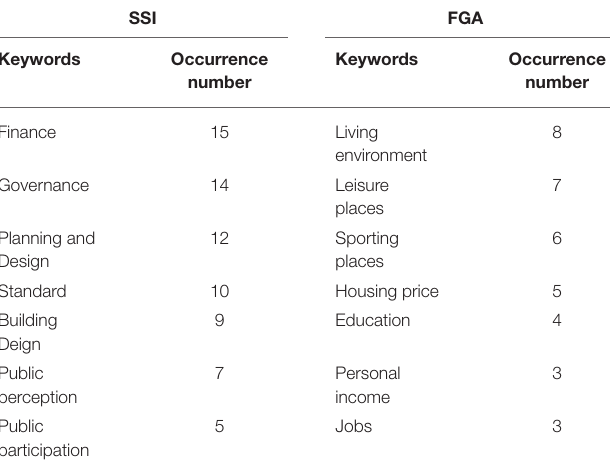
TABLE 2 | The mentioned times of hot topics. SSI